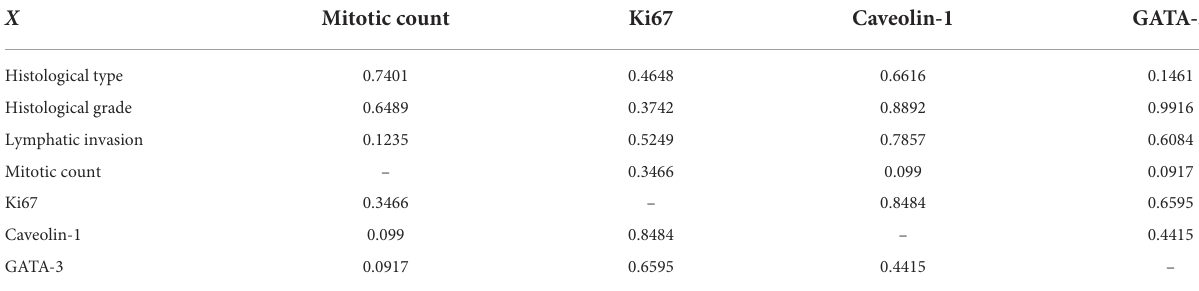
TABLE 2 P values for the univariate